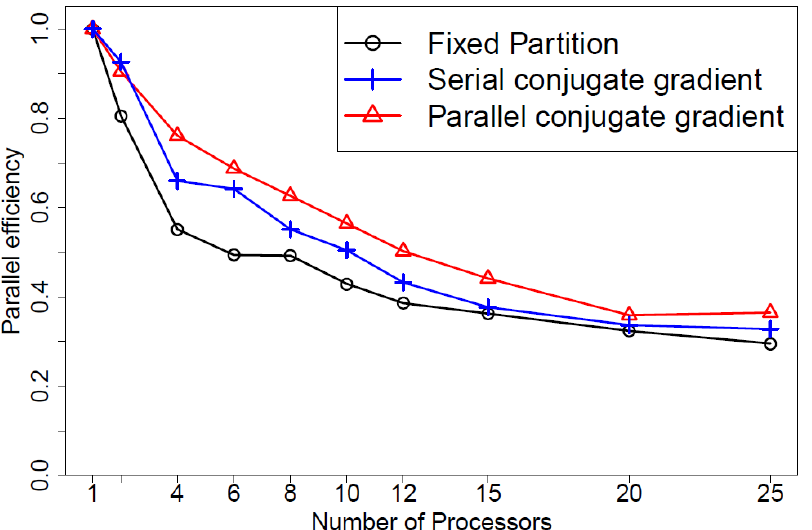
Figure 2. Parallel efficiency as a function of the number of processors using IBM’s MPI-parallelized